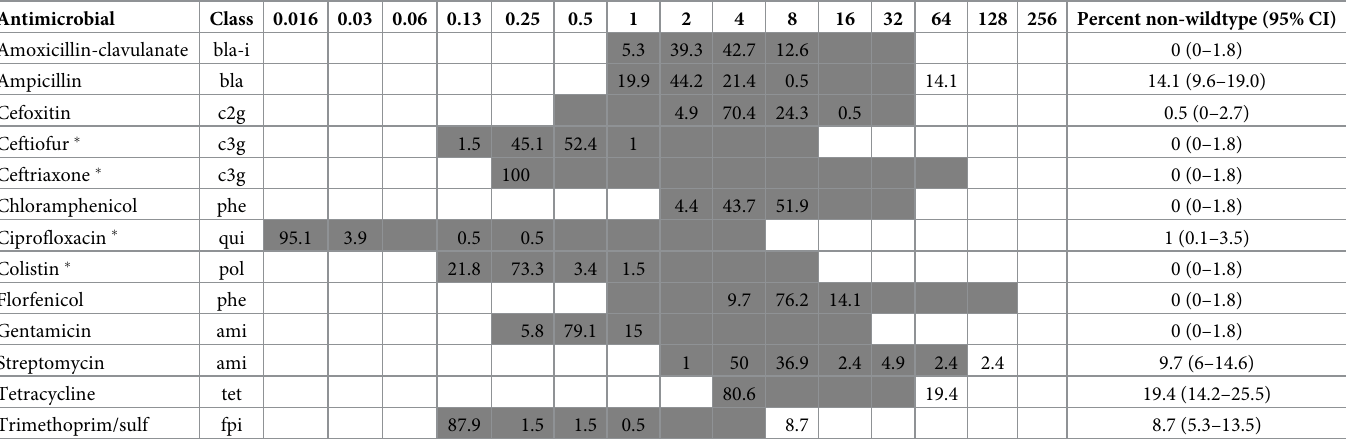
The shaded areas indicate the range of dilutions tested for each antimicrobial. ECOFF values are shown with vertical bars. ami = aminoglycosides, bla = beta lactams,